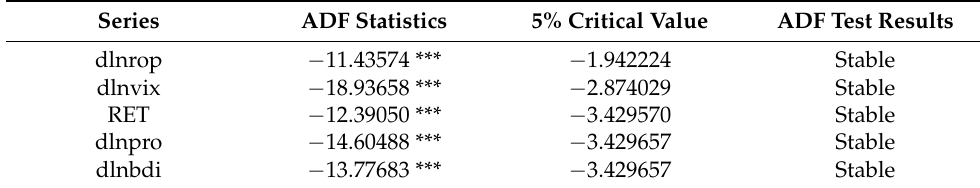
Table 2. Unit root test.